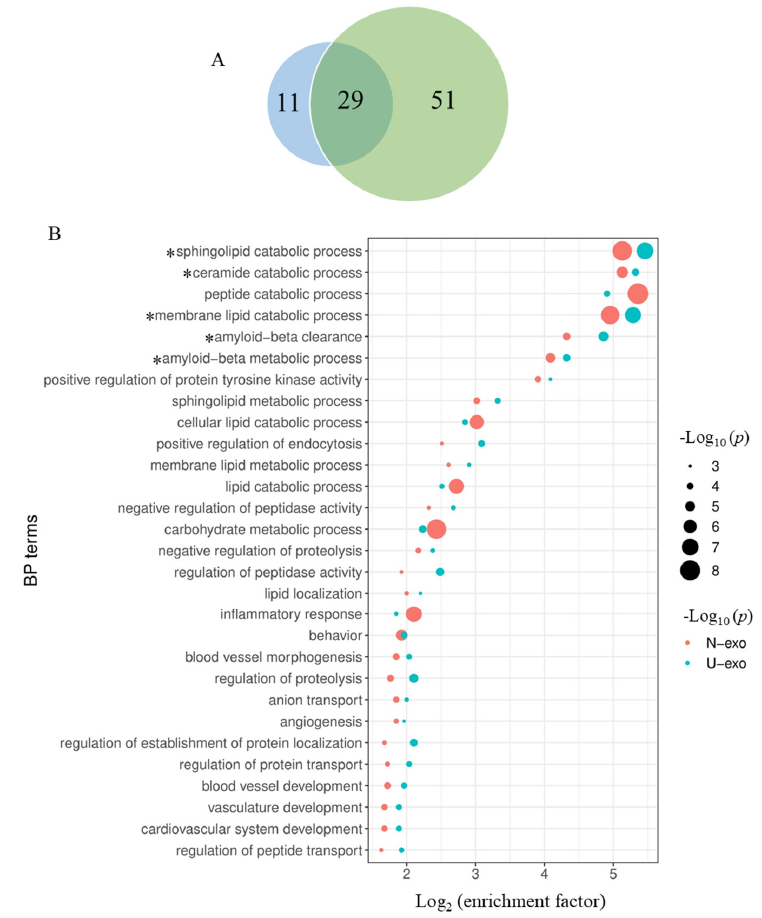
Figure 7. Comparison of the BP enrichment analysis between the identified proteins of U-exo and N-exo. ( A ) Venn diagram showing the enriched BP terms of the identified proteins in U-exo and N-exo. The blue area represents the enriched BP terms of the identified proteins in U-exo, while the green area represents the enriched BP terms of the identified proteins in N-exo. ( B ) Dot bubble plot for displaying the overlapped enriched BP terms between U-exo and N-exo. Pathway enrichment is measured by p value and enrichment factor. Node color represents the sample group (red represents the N-exo group and blue represents the U-exo group). The size of the nodes is arranged in descending order of the − log10 ( p value). The x-axis represents log2 (enrichment factor). The enriched BP